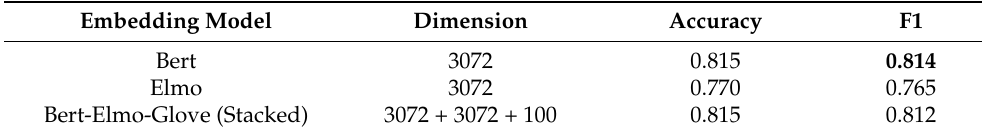
Table 15. Contextualized embedding